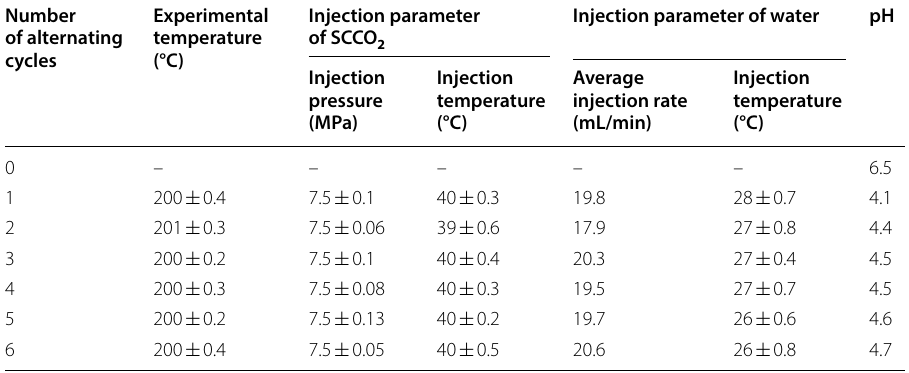
Table 2 Fluid injection parameters and changes of water sample pH in each alternating cycle Number of alternating